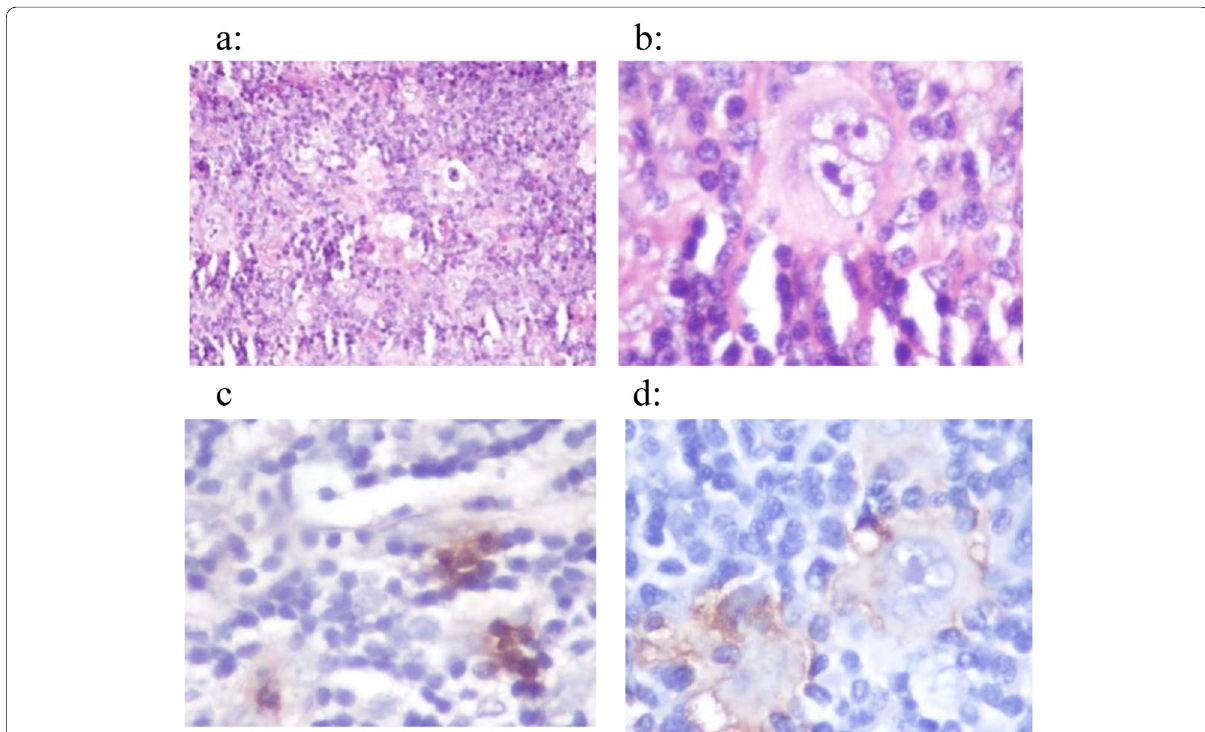
Fig. 2 Legend: Lymph node biopsy histopathology showing a polymorhous population with neutrophils, eosinophils, lymphocytes, and RS cells; b RS cell; c CD 15 positivity; d CD 30